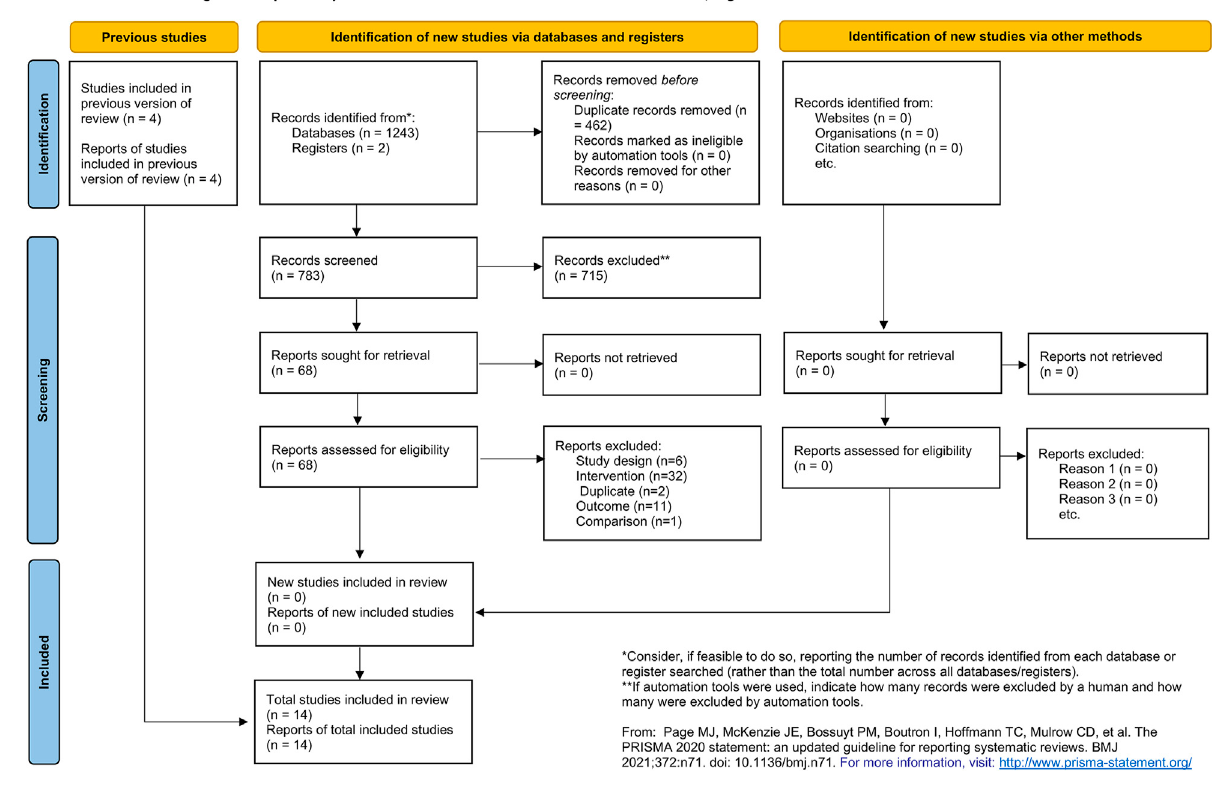
FIGURE 1 | PRISMA fl ow